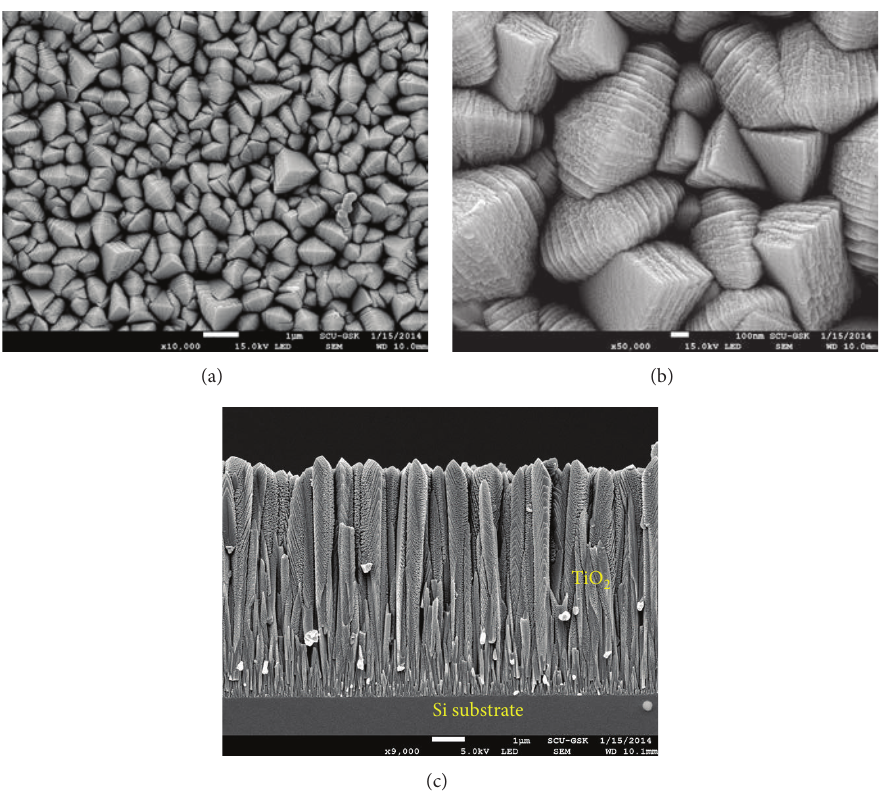
Figure 4: Surface and cross-sectional morphology of TiO 2 films prepared by the CVD methods. Deposition time: 4 hours; deposition temperature: 773